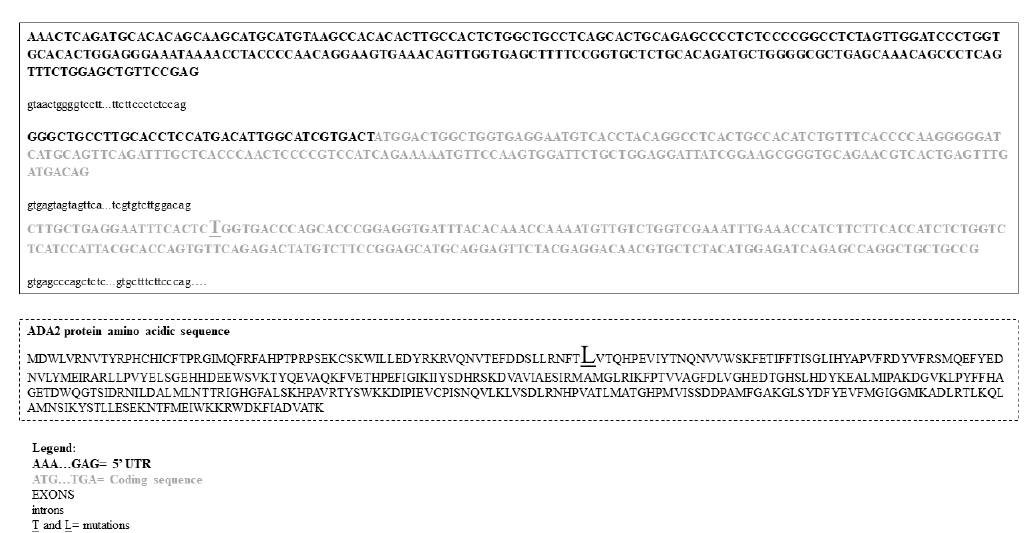
Figure 7. Within the solid box, a partial DNA sequence of ADA2 gene is reported, while in the dashed box the corresponding amino acid sequence of ADA2 protein is depicted. The larger and underlined letters indicate the gene mutation (T) and amino acid substitution in the corresponding protein (L), respectively.